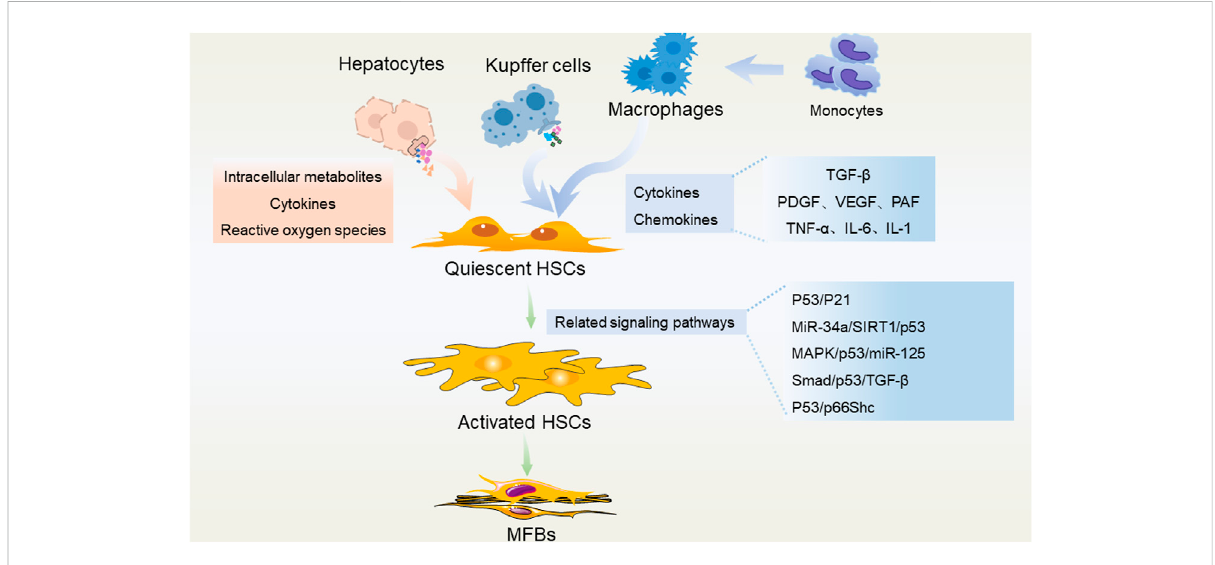
P53 in regulating different liver cells during the development of liver fi brosis. Hepatocytes, liver macrophages (Kupffer cells and recruited monocyte-derived macrophages) secrete a variety of intracellular metabolites, cytokines, chemokines, reactive oxygen species, etc., and activate HSCs through a variety of p53-related pathways. These pathological stimulations could promote the trans-differentiation of HSCs into MFBs, and subsequently lead to liver fi